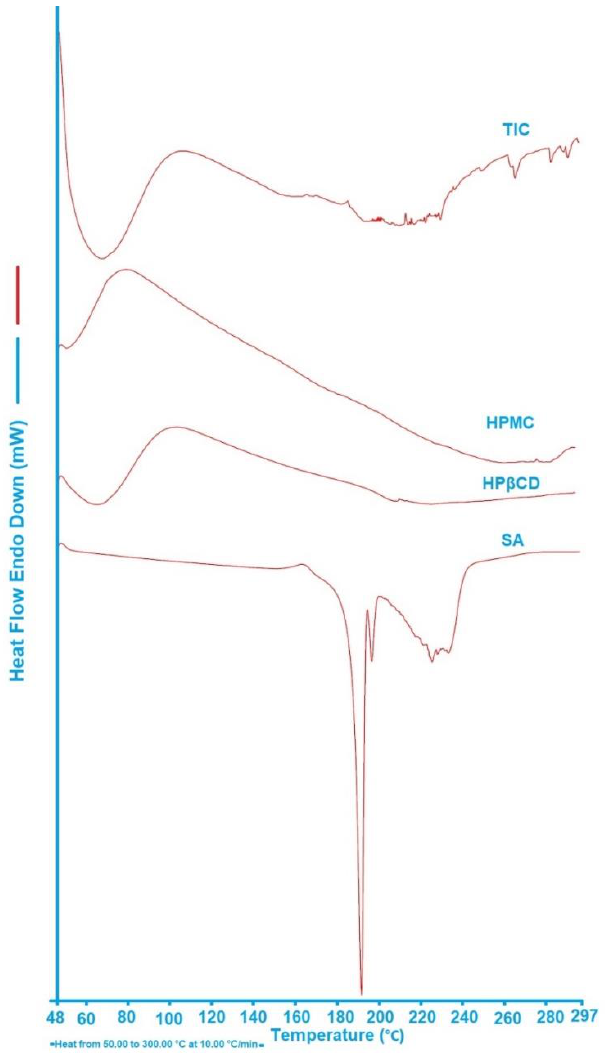
Figure 3. DSC thermograph of SA, HPβCD, HPMC , and TIC.